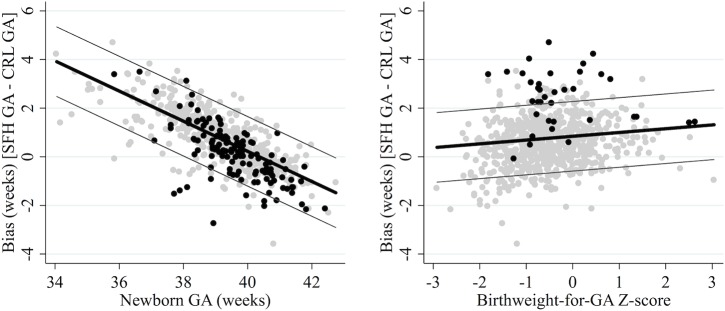
Agreement between CRL biometry and the SFH formula.Reference standard: crown-rump length (CRL) biometry. SFH: symphysis-fundal height. True gestational age determined from CRL biometry. Thick black lines represent the mean bias of the SFH formula in reference to CRL biometry; the thin grey lines represent the 95% limits of agreement. Grey dots are observed values for newborns with normal birthweight for GA (left) or term newborns (right); black dots are observed values for SGA newborns (left) or preterm newborns (right).